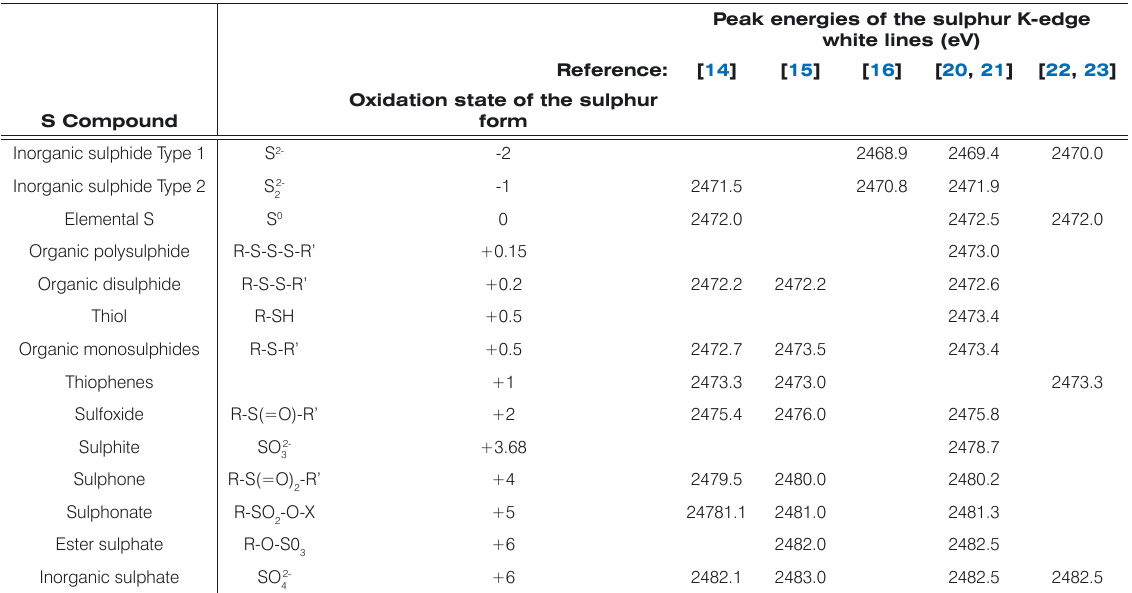
Table 1. Energy position of the sulphur K-edge white line for different sulphur compounds from literature data: coal [14], petroleum and asphaltenes [15], minerals [16], soils [19-21], residual oil fly ash [22,23].